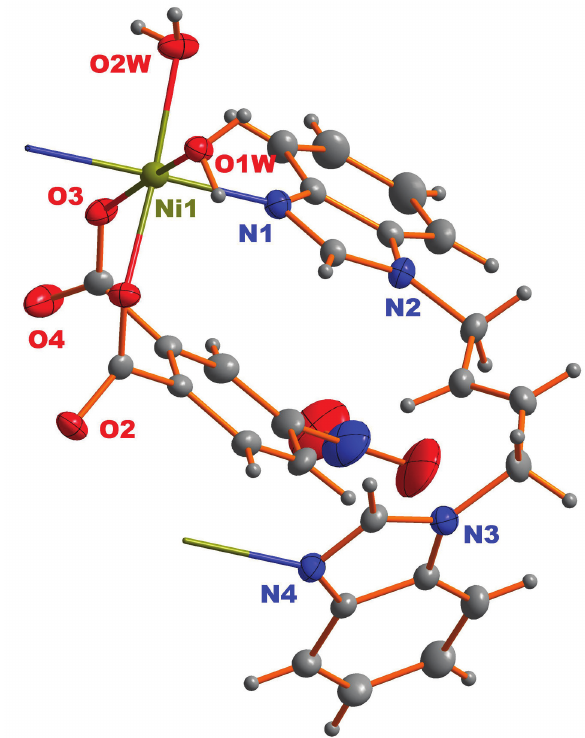
Table 1: Data collection and